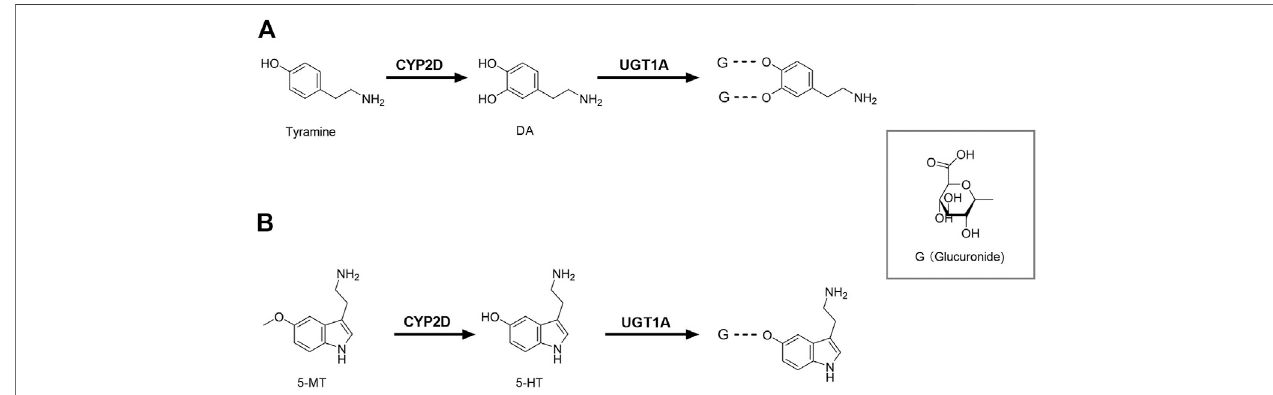
FIGURE 1 | Brain CYP2D and UGT1A mediate the metabolism of DA (A) and 5-HT (B) . CYP2D, Cytochrome P450 2D; DA, dopamine; G, glucuronide; UGT1A, UDP-glucuronosyltransferase 1A; 5-HT, serotonin; 5-MT, 5-methoxytryptamine.